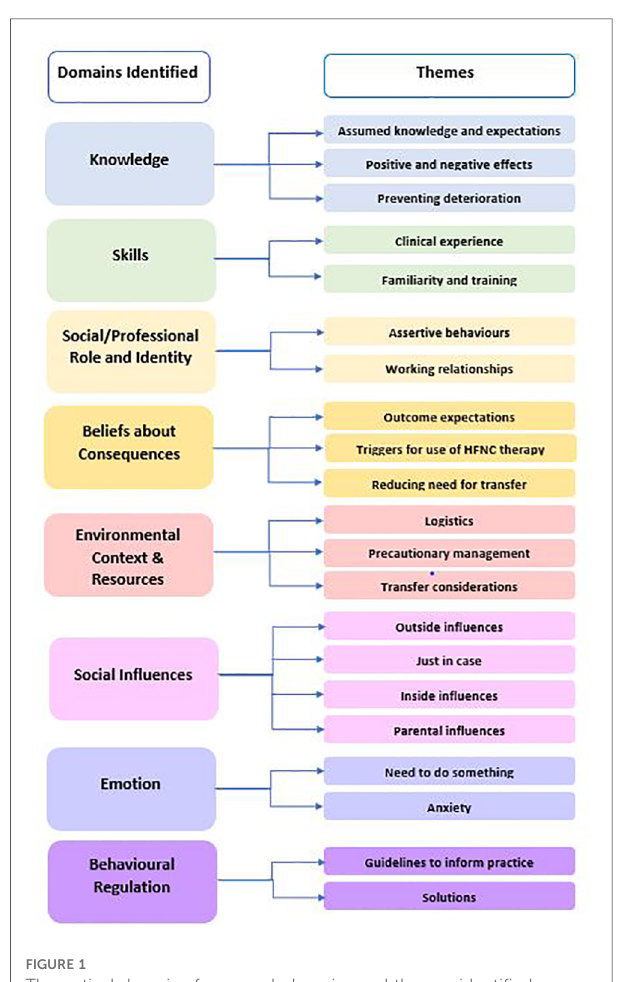
FIGURE 1 Theoretical domains framework domains and themes identi fi